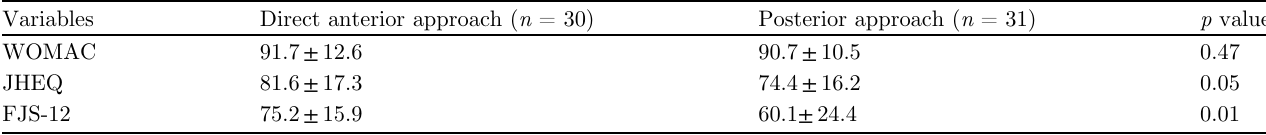
Table 4. Patient-reported outcomes at 3 years after